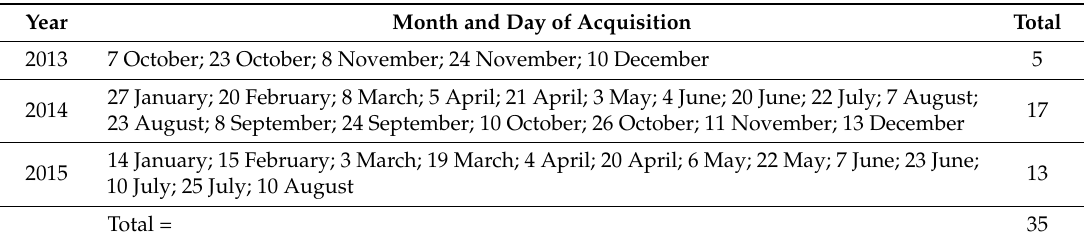
Table 1. List of available COSMO-SkyMed (CSK)